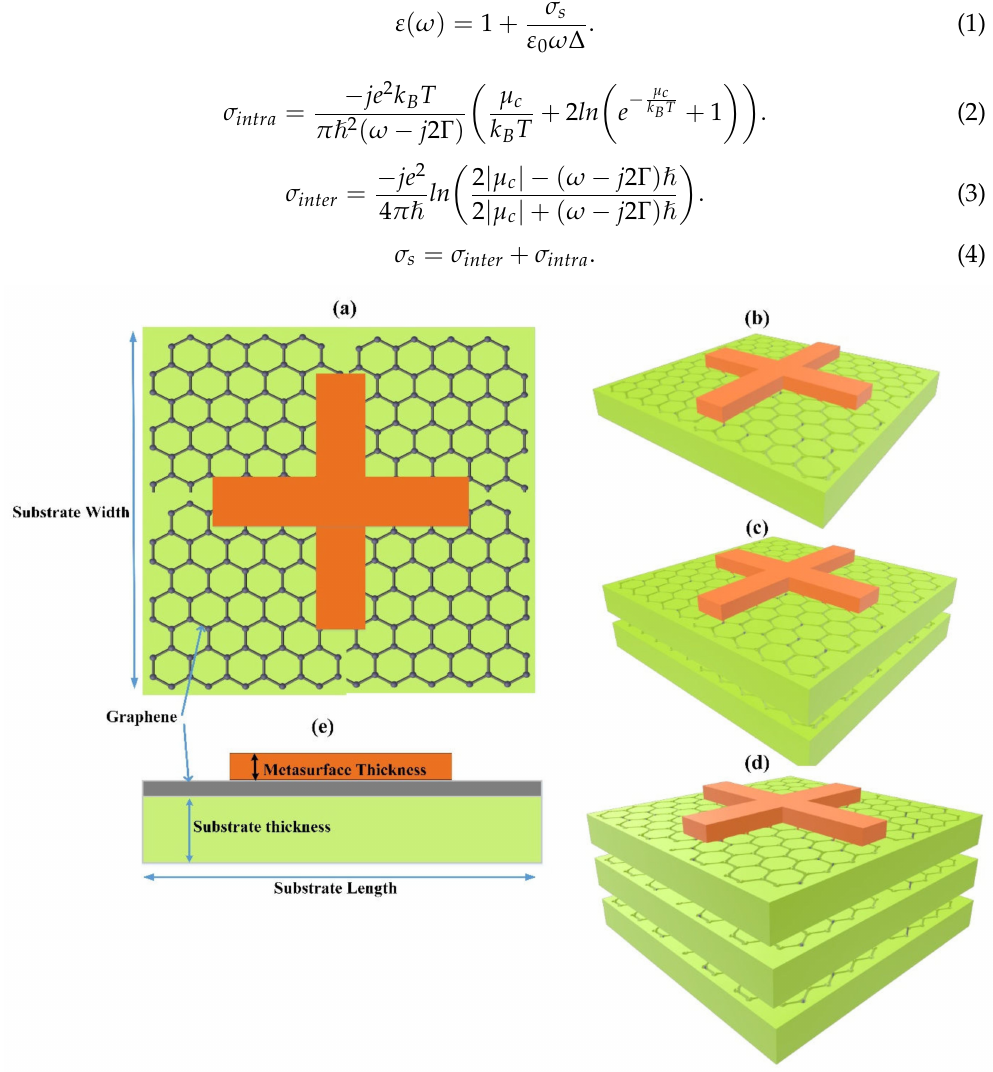
Figure 1. Multilayer metamaterial design. ( a ) Plus-layer top view; ( b ) single layer; ( c ) two layers; ( d ) three layers; ( e ) single-layer front view. Three layers are added periodically one over the other with substrate and plus-shape metamaterial as a periodic component. Metasurface thickness is 1000 nm and substrate thickness is 2500 nm. Substrate length and width are kept at 5000 nm. The light is falling from the top of the